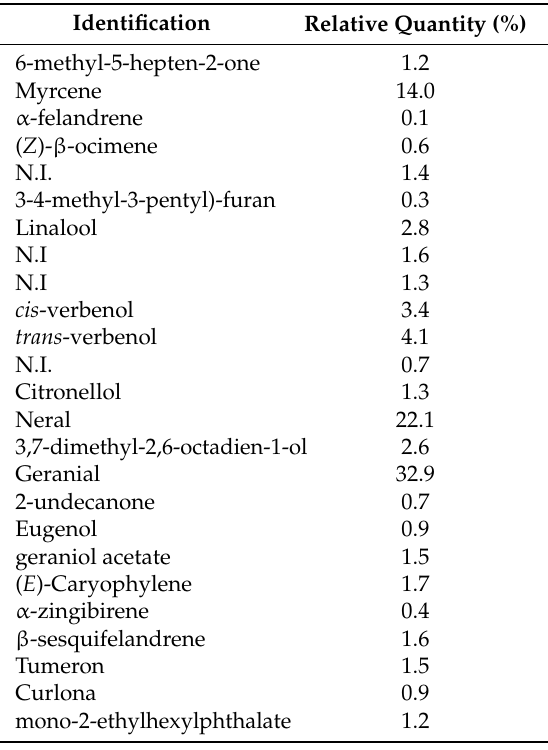
Table 1. Ratio of essential oil components of Cymbopogon